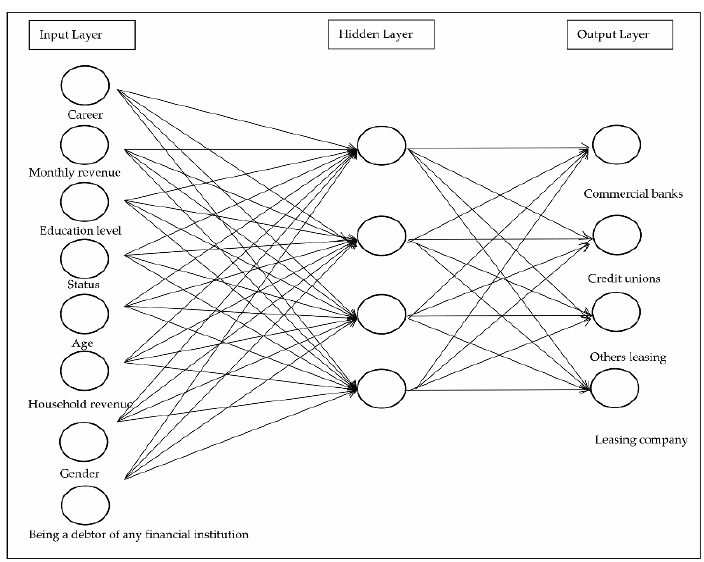
Figure A1. Structure of the NN by considering only the basic feature model used for predicting.